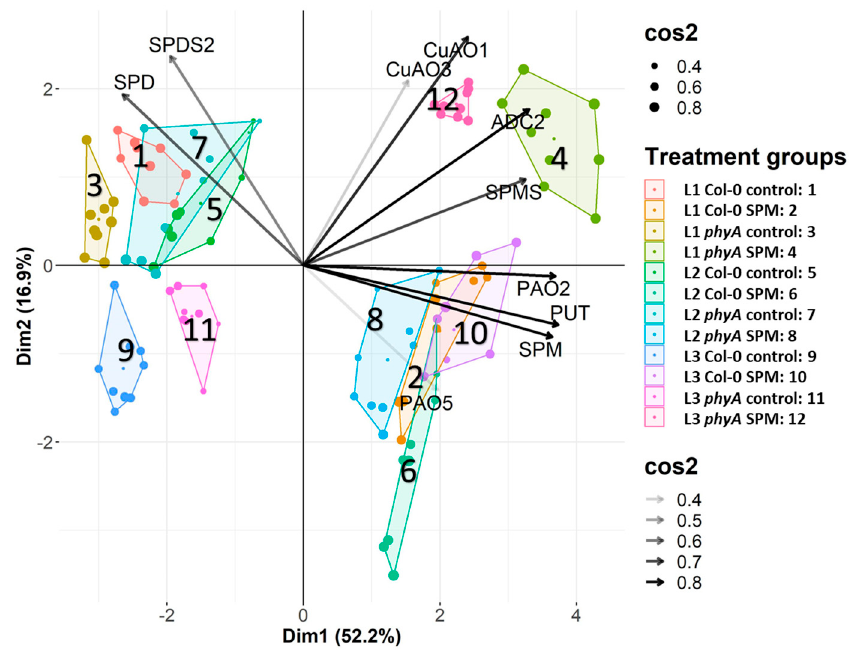
Figure 5. The biplot illustration of PCA analysis was carried out on the standardized concentration values of polyamines and the relative expression values of polyamine metabolism-related genes. Squared cosine (cos2) shows how accurate the representation of our variables or individuals on the PC plane is. Dim1 and Dim2 are equivalent to principal components 1 and 2 (PC1 and PC2). Inves-